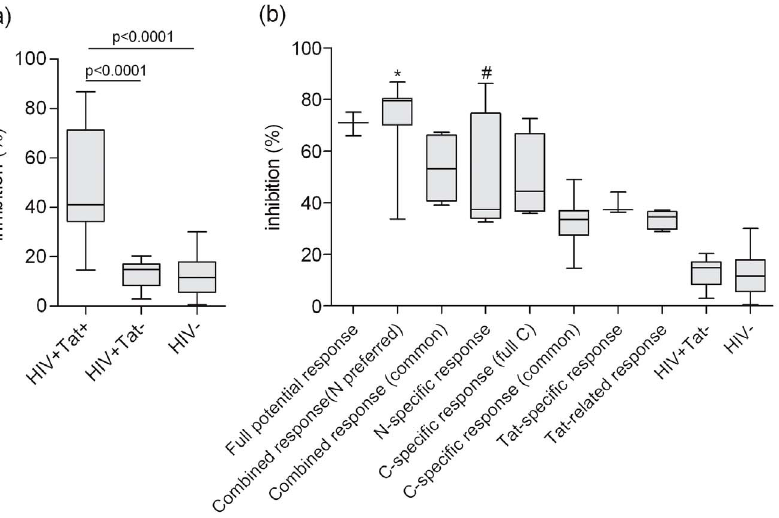
Figure 4. Comparison of Tat-neutralizing potential of plasma samples. (a) Antibody-mediated neutralization of exogenous recombinant full- length Tat. The percent inhibition of transactivation at 48 h was plotted on the y-axis with the following samples on the x-axis: HIV + Tat + , HIV-1- seropositive and anti-Tat-seropositive plasma; HIV + Tat-, HIV-1-seropositive and anti-Tat-seronegative plasma; and HIV-, healthy blood-donor plasma. The data on the y-axis represent the inhibition of the SEAP release in the culture supernatant of HEK293T cells, as described in the ‘‘Materials and Methods’’ section. The boxes represent the interquartile range, the line inside each box represents the median of the samples and the whiskers represent the range of the data. Statistical significance was tested using Wilcoxon non-parametric test. (b) A comparison of eight Tat-antibody reactive types in the six response profiles and percent inhibition of transactivation. The percent inhibition at 48 h was plotted on the y-axis with samples classified by Tat antibody response profile on the x-axis. Statistical significance was tested using Nemenyi non-parametric test. * p , 0.05 comparing HIV + Tat- and HIV- groups. # p , 0.05 comparing HIV- group.